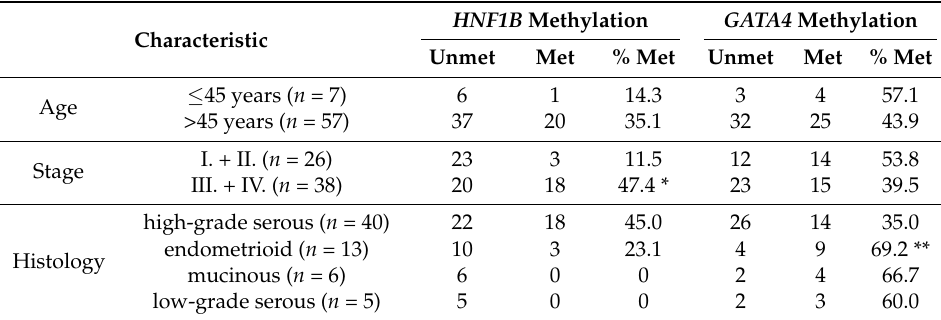
Table 1. Methylation of genes and clinicopathological characteristics.